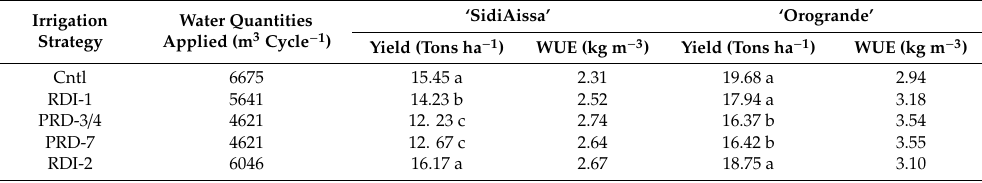
Table 4. E ff ect of irrigation strategies on total water applied during the crop cycle, yield and water use e ffi ciency (WUE) for ‘Sidi Aissa’ and ‘Orogrande’ clementine trees. Irrigation Strategy